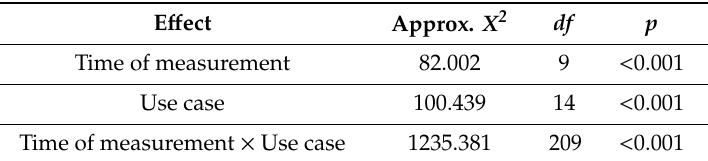
Table 3. Mauchly-test statistics of sphericity assumption for time on task.